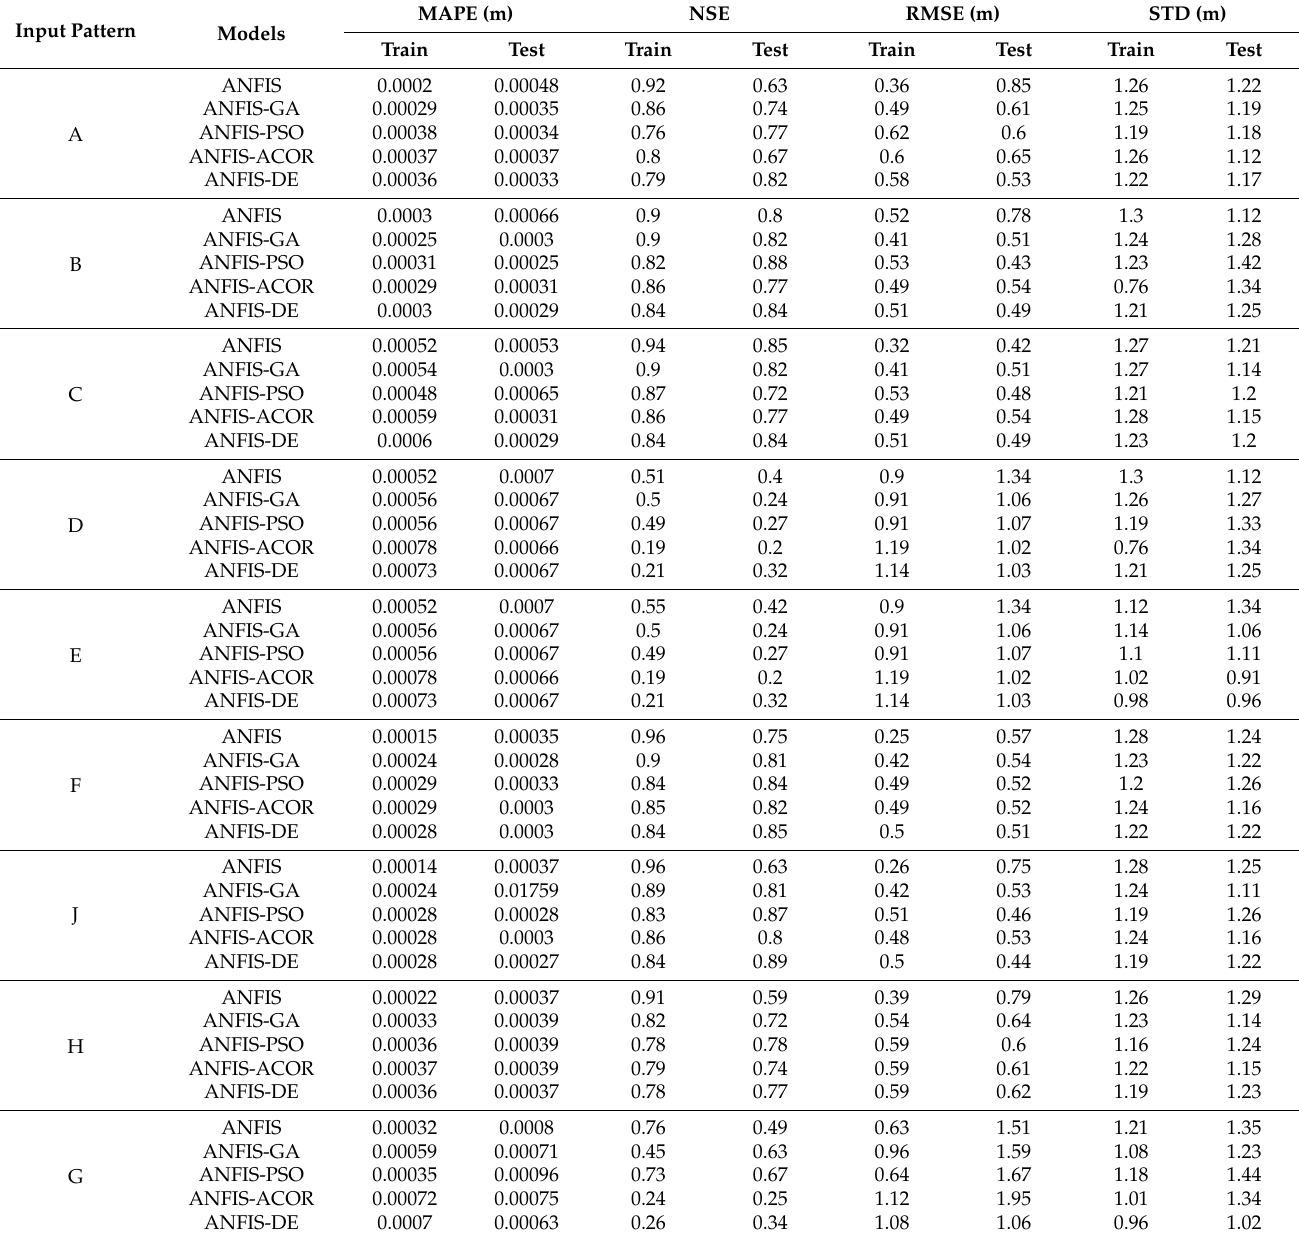
Table 6. Evaluation criteria of studied input patterns using different models for the observation well